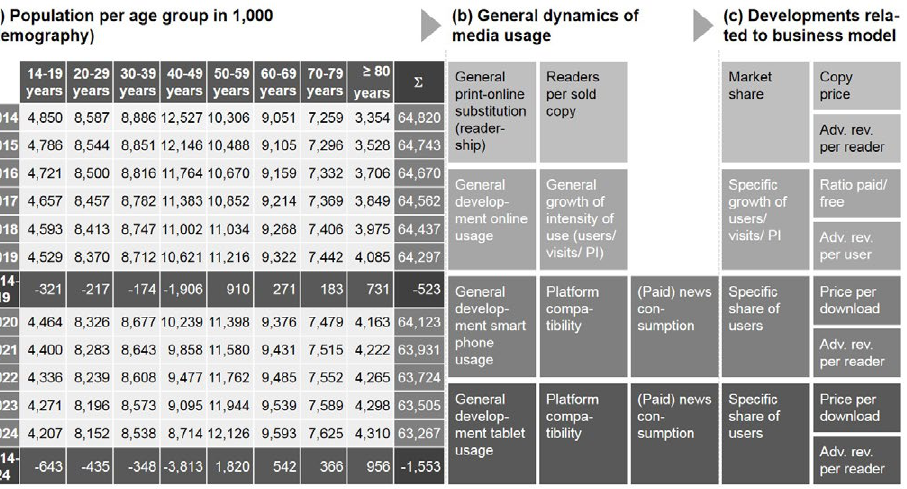
Figure 6: Key elements of the revenue model. Source : Own elaboration; demographic data based on Statistisches Bundesamt